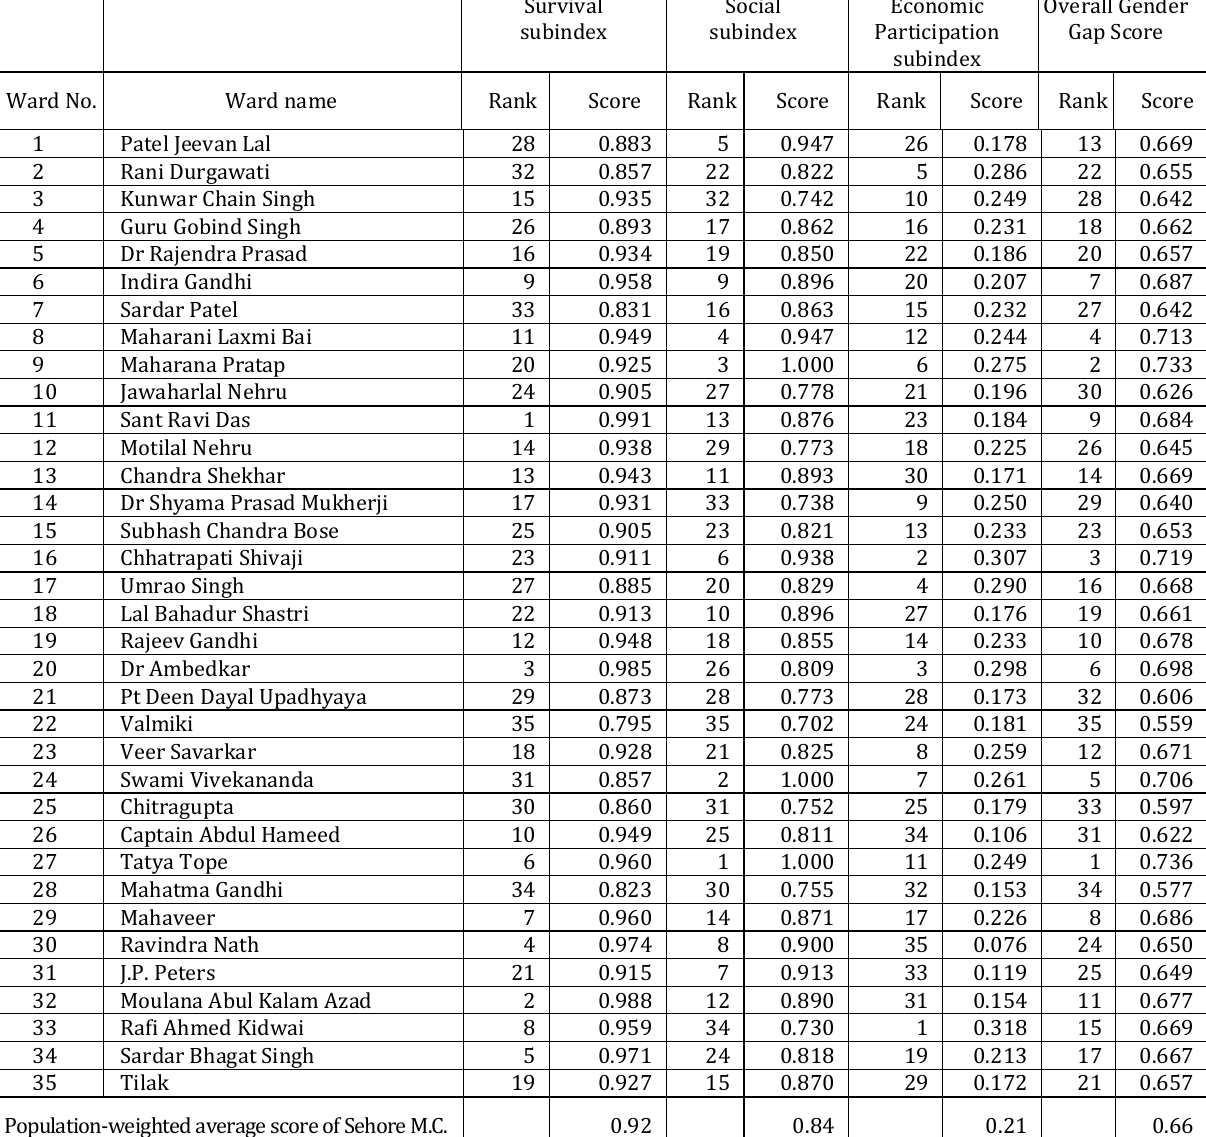
Table 4. Overall scores of Gender Gap Index, Sehore M.C., M.P.,